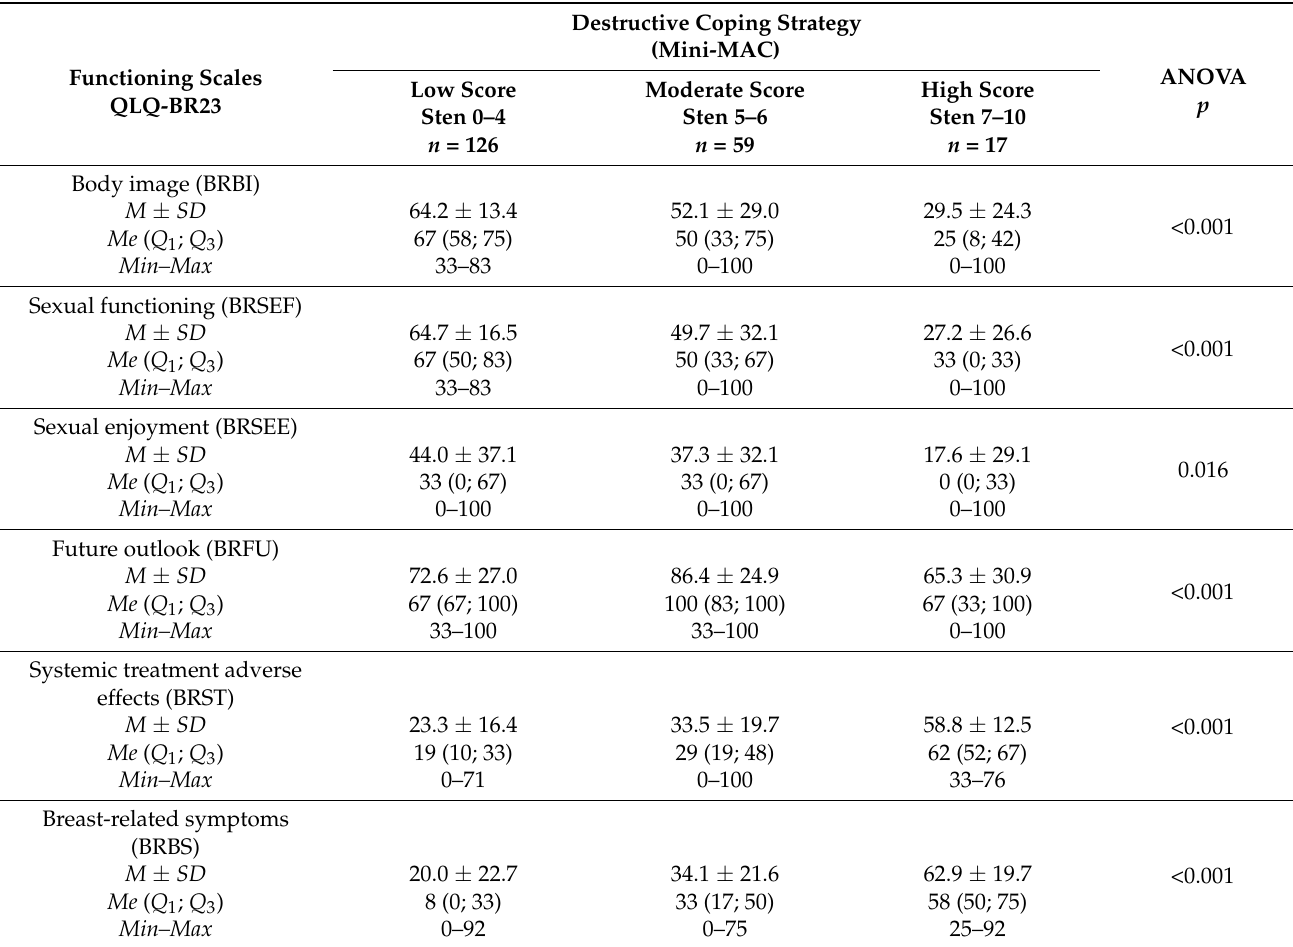
Table 8. Quality of life (EORTC QLQ-BR23 scores) in patients differing in terms of scores for the destructive coping strategy, with analysis of variance